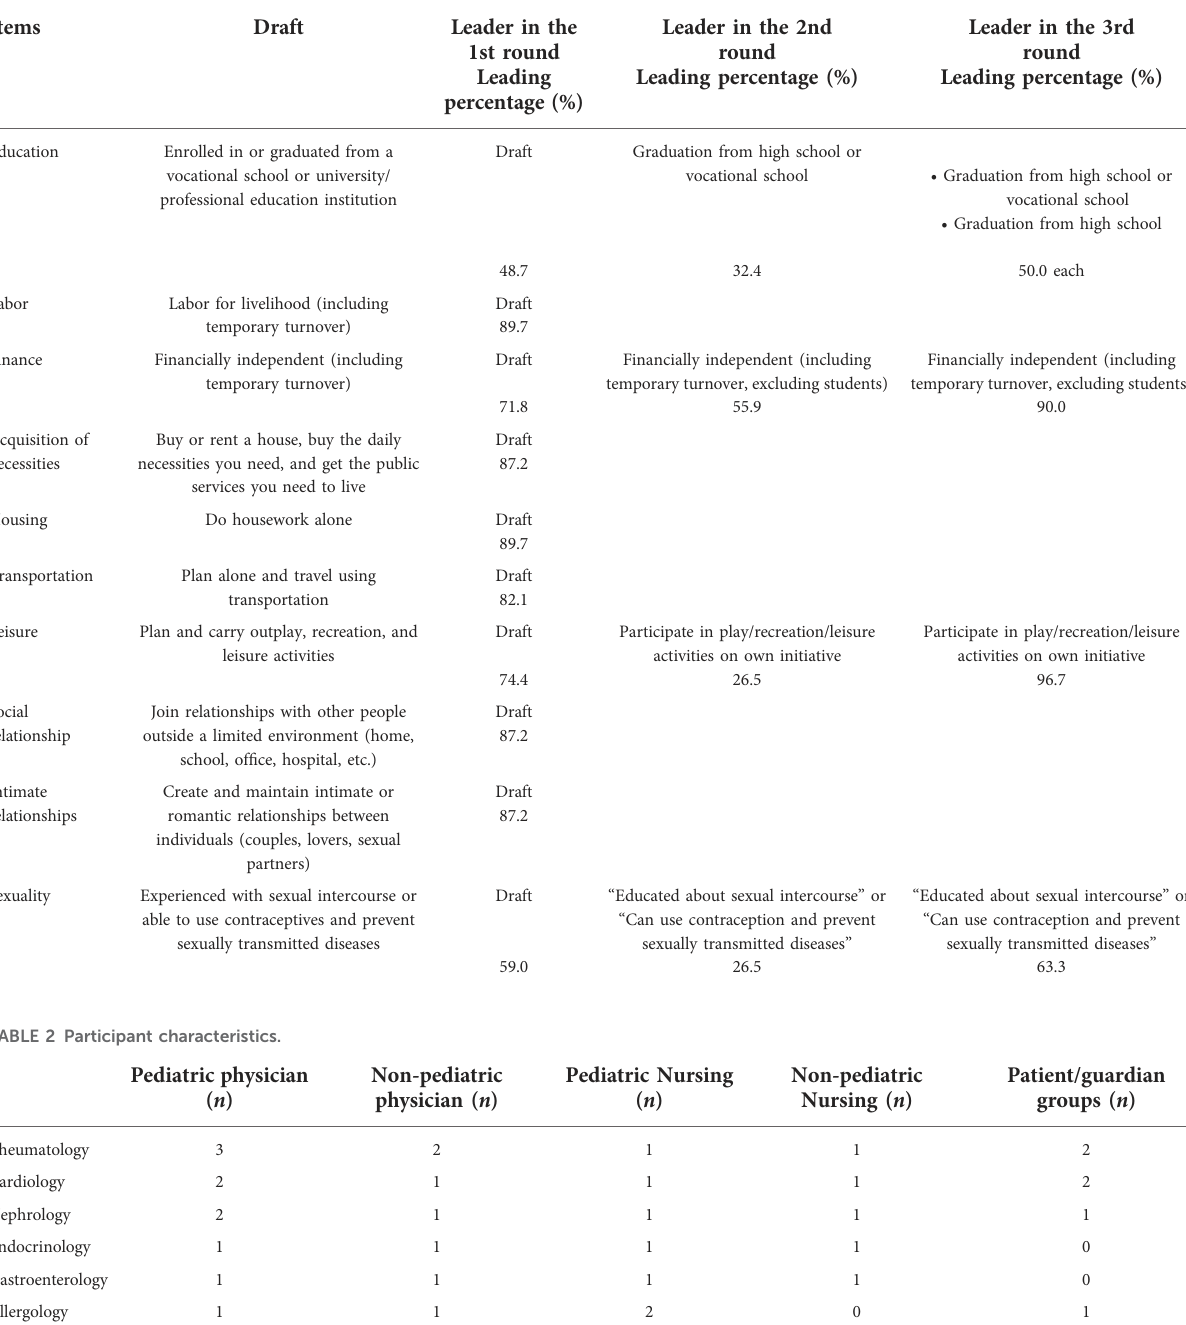
TABLE 1 Original draft and voting results in the three Delphi rounds.